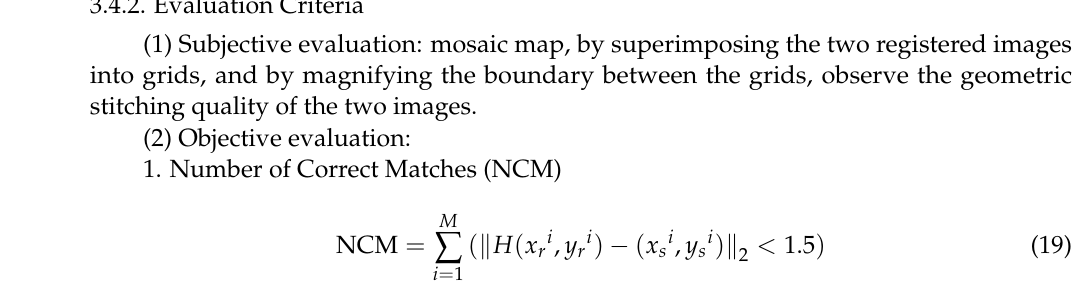
Figure 15. Optical and SAR images. ( a1 – g1 ) Optical images; ( a2 – g2 ) SAR images. Table 2. The experimental parameter settings of each method.